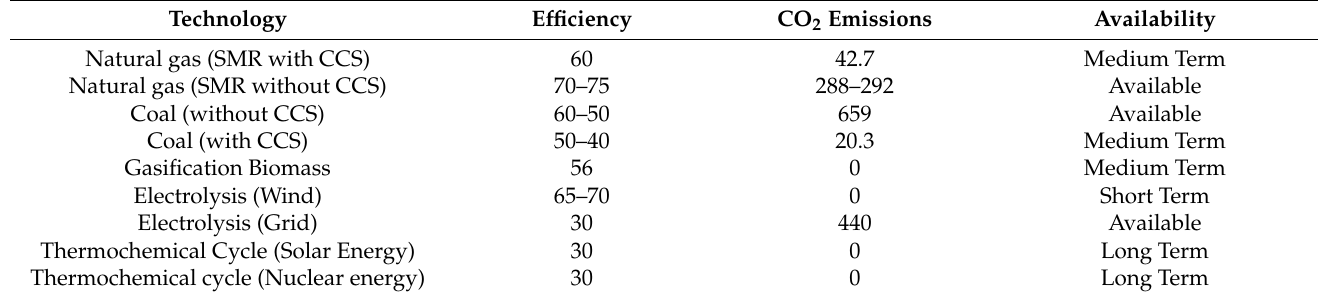
Table 5. Efficiency and availability of generation mechanisms for hydrogen production [42].